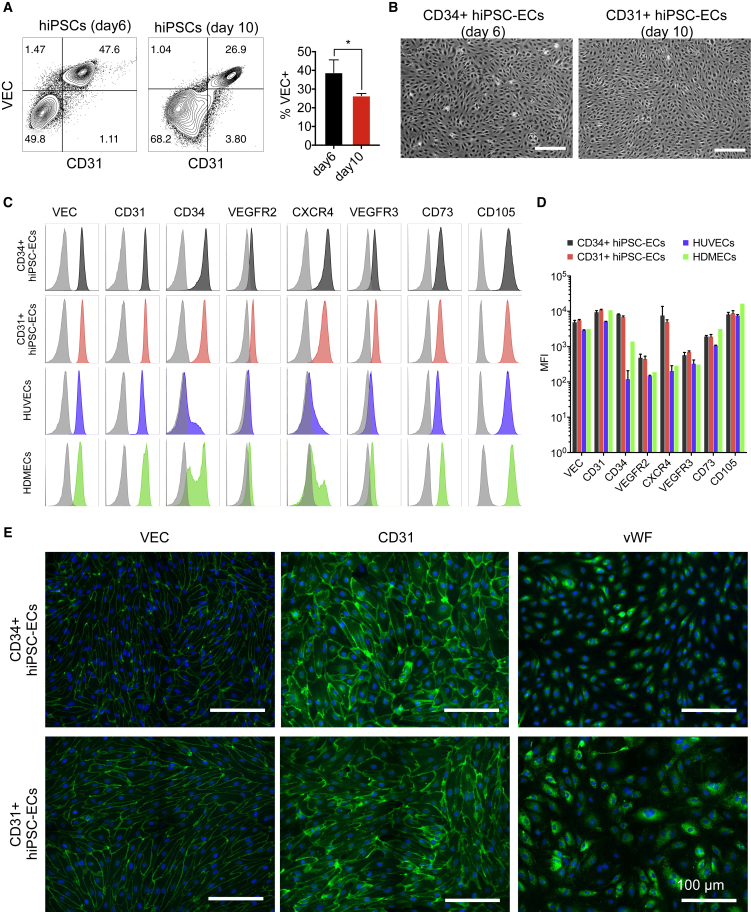
Differentiation of hiPSCs toward ECs(A) Representative FACS plots and quantification of the percentage of VEC+ cells at day 6 and day 10 differentiation of UiPSCs. Average %VEC+ from three independent biological replicates are shown, error bars represent ±SD. ∗p < 0.05.(B) Phase-contrast images of CD34+ and CD31+ hiPSC-ECs 3 days post isolation. Scale bar represents 300 μm.(C) FACS analysis of surface marker expression on isolated CD34+ and CD31+ hiPSC-ECs at passage 2 (P2) and primary ECs (HUVECs and HDMECs at P4–P5). Black and color filled histograms are staining with the antibody of interest; light gray histograms are relevant isotype control.(D) Quantification of surface marker expression on isolated CD34+ and CD31+ hiPSC-ECs at passage 2 (P2). Median fluorescence intensity values are shown for three batches of CD31+ and CD34+ hiPSC-ECs, HUVECs from three batches (two donors, and two independent batches for one of the donors) and HDMECs from a single donor. Error bars represent ±SD.(E) Immunofluorescent analysis of EC markers VEC, CD31, and vWF on isolated CD34+ and CD31+ hiPSC-ECs (P2). Scale bar represents 100 μm.